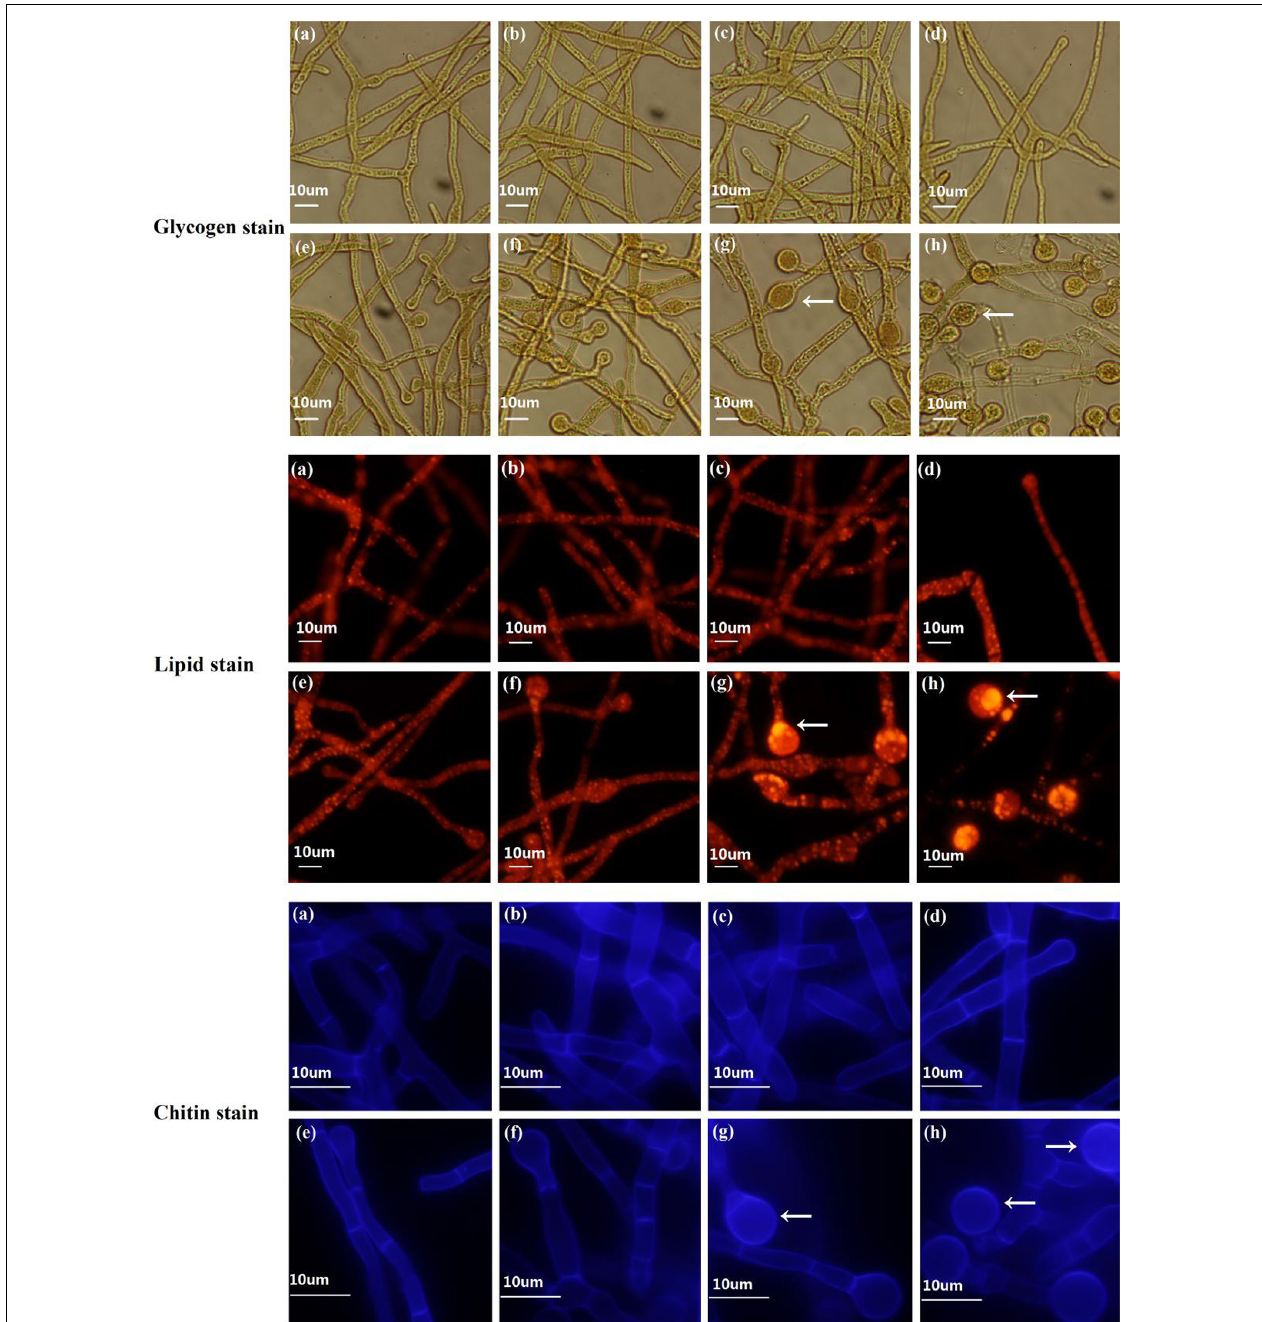
FIGURE 4 | Fluorescence staining to determine dynamic changes in chlamydospore components in T. virens GV29-8. Glycogen, lipid, and chitin components were stained with KI and I 2 , nile red and calcofluor white, respectively. (a–h) represent the samples of TVS1, TVS2, TVS3, TVS4, TVS5, TVS6, TVS7, and TVS8 of T. virens GV29-8, respectively. Scale bar = 10 µ